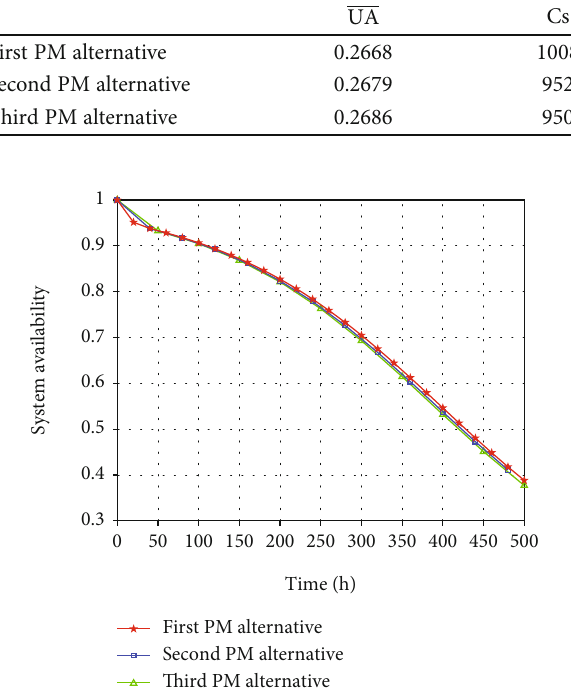
Figure 9: System availability trajectory with